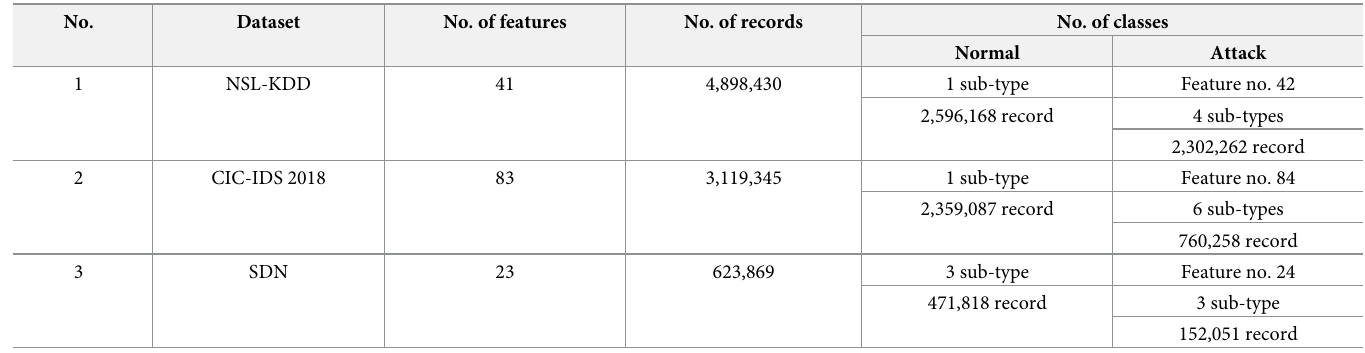
Table 3. A list of datasets used for the evaluation in the paper. No.